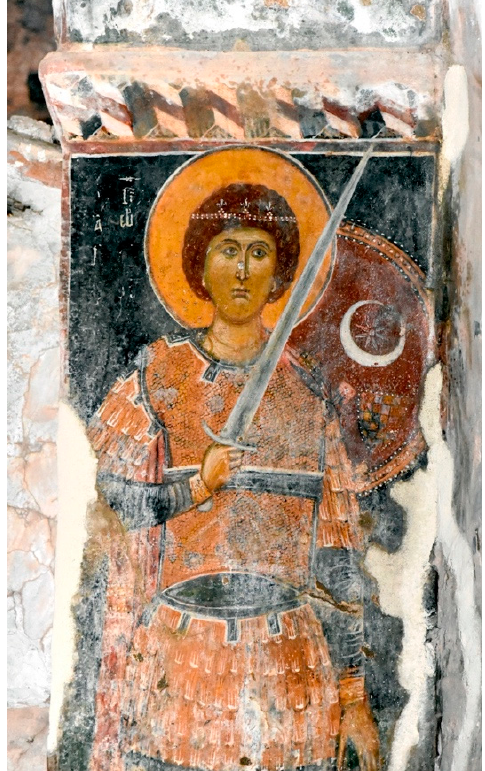
Figure 35. Mural depictions of St George standing and wearing the shield with the coat of arms of the family Alfafro, chapel of Hagios Georgios in the castrum of Geraki, central nave, NE pier, west side, 1378–1381. © Used with permission of the Ephorate of Antiquities of Lakonia, Hellenic Ministry of Culture and Sports/Archaeological Resources Fund.